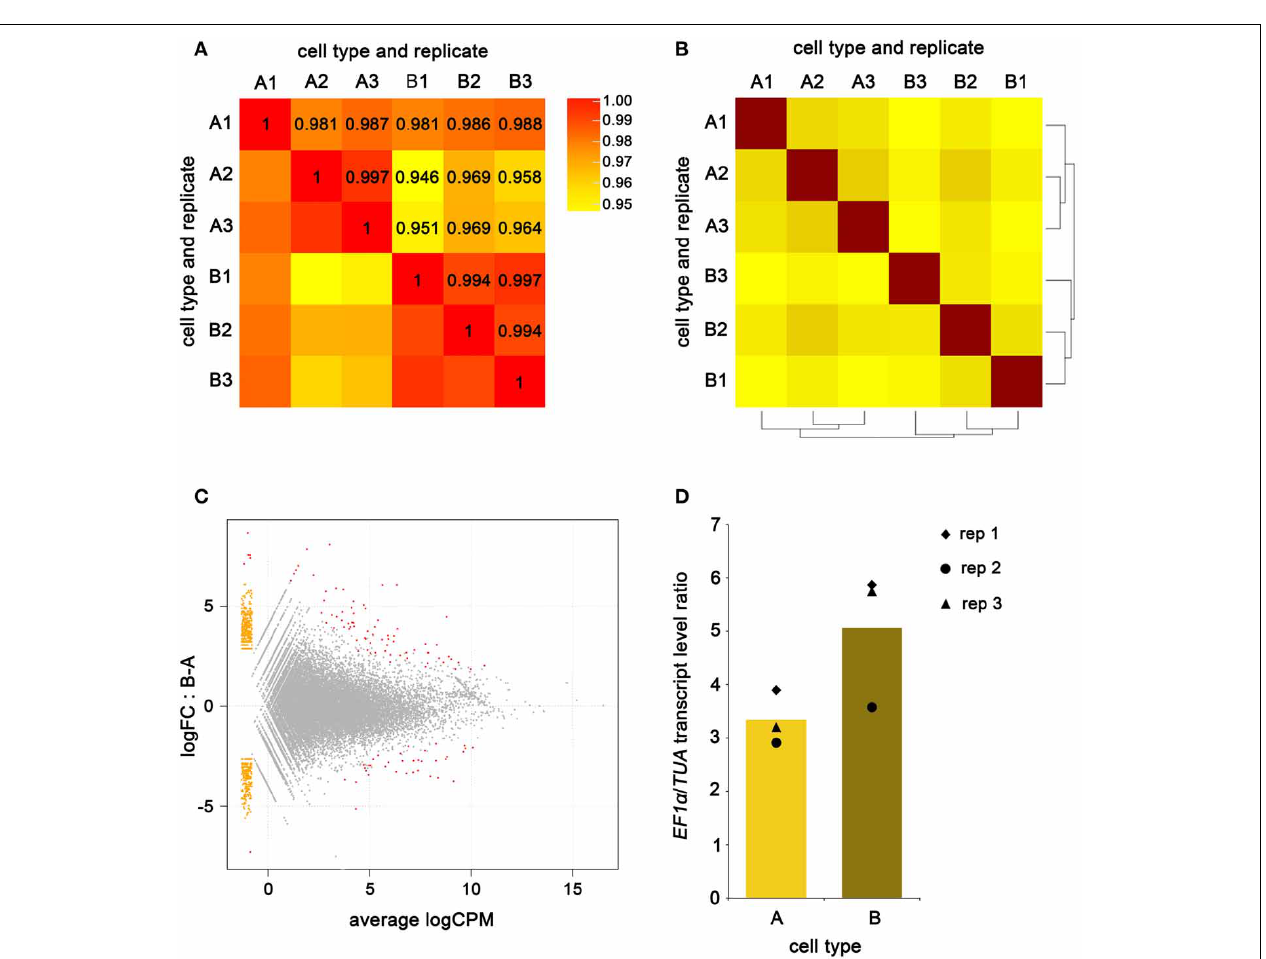
FIGURE 6 | Analysis of A-type and B-type cell transcriptomes. Pairwise read count Pearson’s correlation between A-type and B-Type cells (A) . Sample clustering of the three biological replicates of A-type and B-type cell transcriptomes (B) . MA-plot showing the differential expressed genes (red dots), non-differentially expressed genes (gray dots) and genes for which one